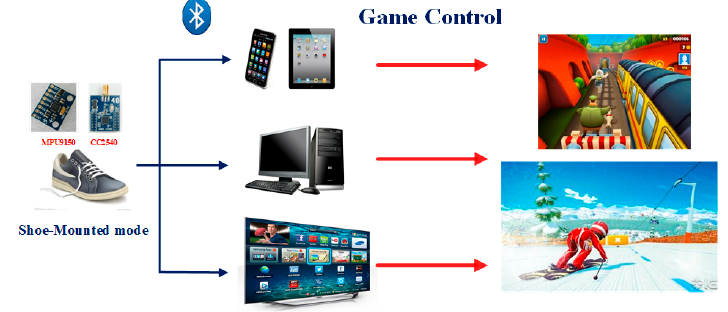
Figure 2. System architecture.